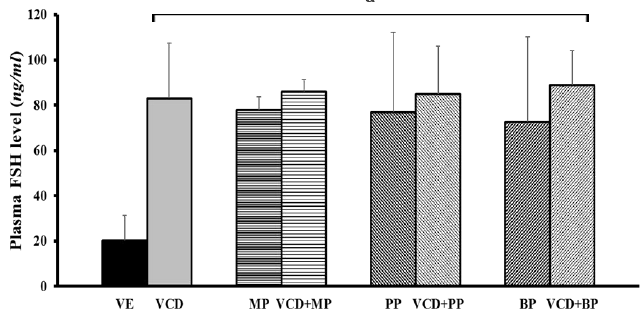
Figure 7. Effect of VCD and parabens on plasma FSH level. Plasma FHS hormone level were measured by ELISA. a p < 0.05 vs. VE. Data are presented as the mean ± SD. VE; 20% Et-OH, VCD 40 mg/kg/day, MP, PP, BP; 100